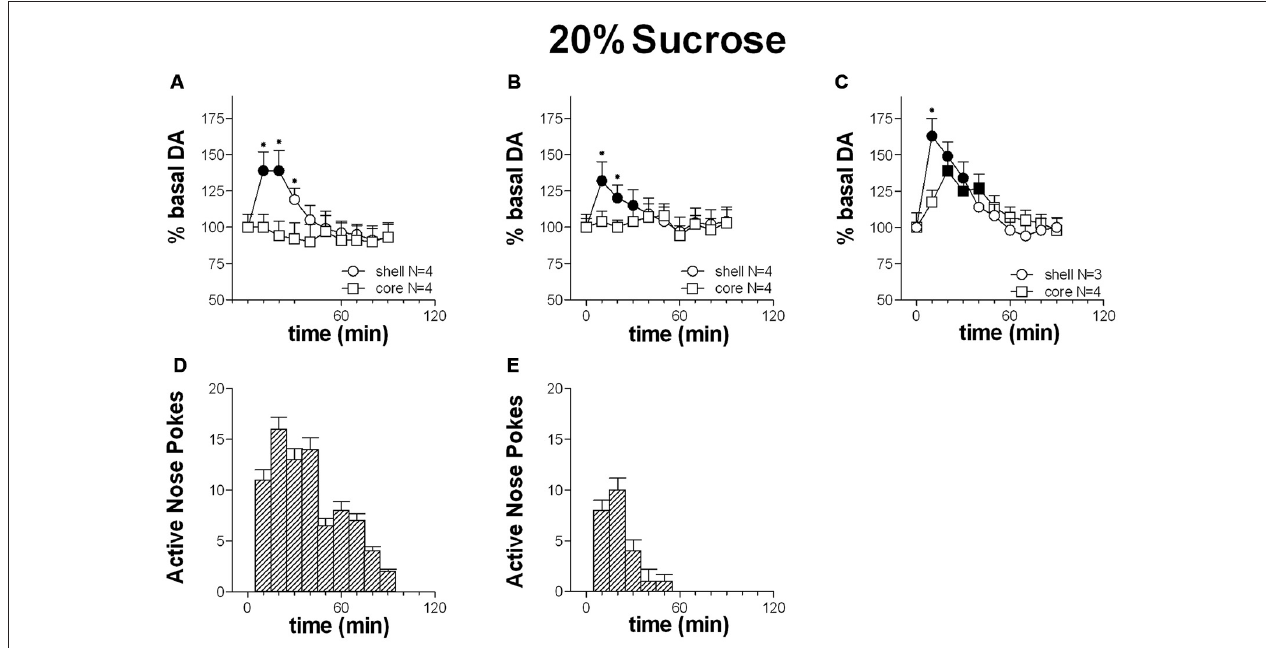
FIGURE 4 | Time-course of dialysate dopamine (DA) in the NAc shell (circles) and core (squares) and active nose pokes (Bars) every 10 min under FR1 responding for 20% sucrose solution (A,D) , extinction (B,E) and non-contingent sucrose presentation (C) . Data are means ± SEM of the results, expressed as % of basal values, obtained in the number ( N ) of rats indicated in the figure. Filled symbols: p < 0.05 vs. basal values; ∗ p < 0.05 vs. values obtained in the